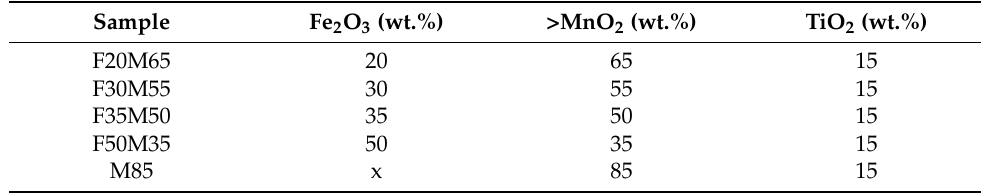
Table 3. The obtained OC